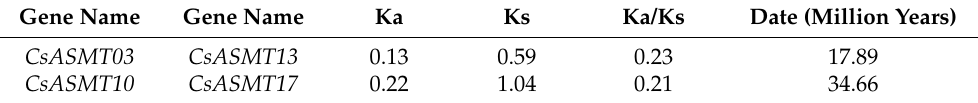
Figure 4. Collinearity analysis of C. sinensis ASMT gene family. The lines between chromosomes indicate a fragmentary replication relationship between ASMT genes in tea plant. Table 2. The parameters and data of the duplication evens in the CsASMTs.